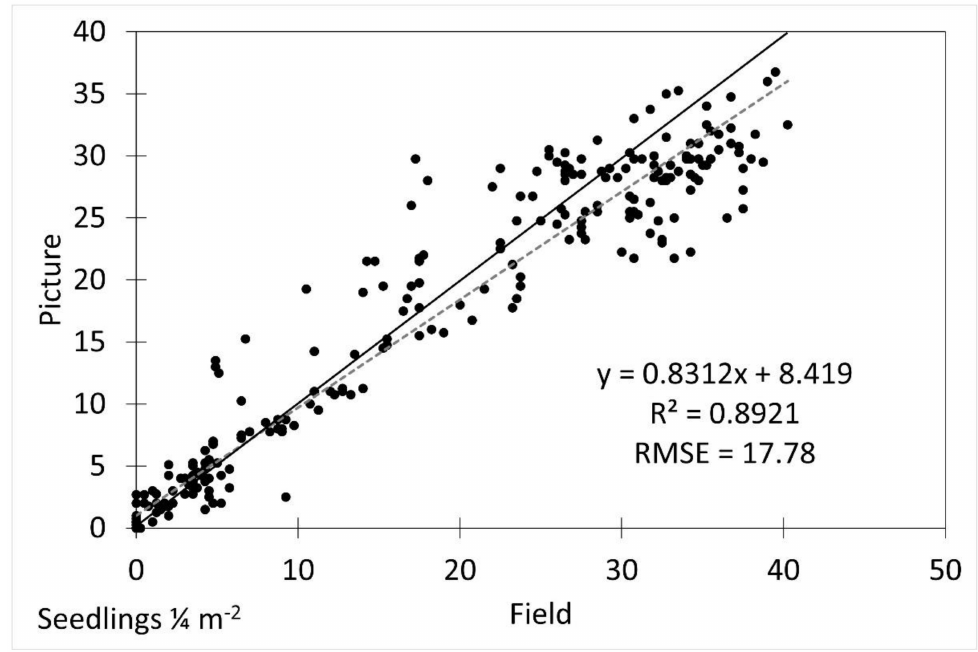
Figure 7. Scatterplot of field vs. picture average seedling density with fitted linear regression line (dotted line) and 1:1 line (solid line). R 2 was 0.8921 and RMSE was 17.78.